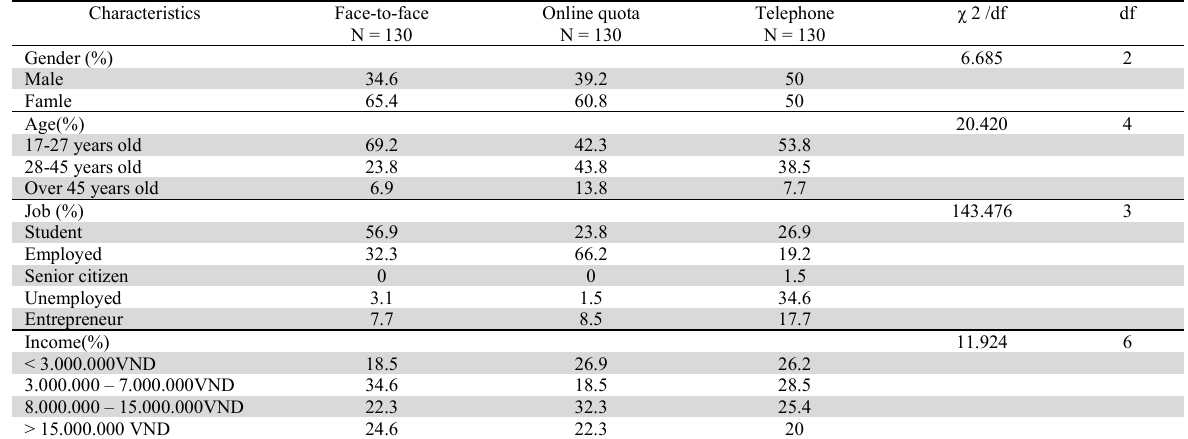
Demographic profile by